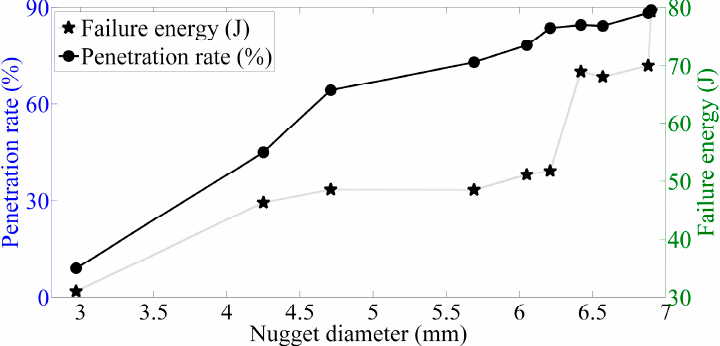
Figure 16. Relationships between the nugget diameter, penetration rate, and failure energy.